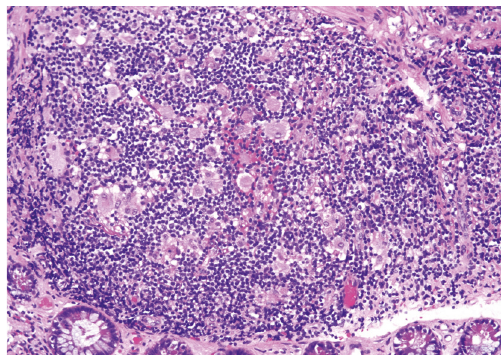
Figure 2: Peyer’s patch at higher magnification (hematoxylin and eosin 200x) contains several scattered pink-coloured, foamy macrophages.